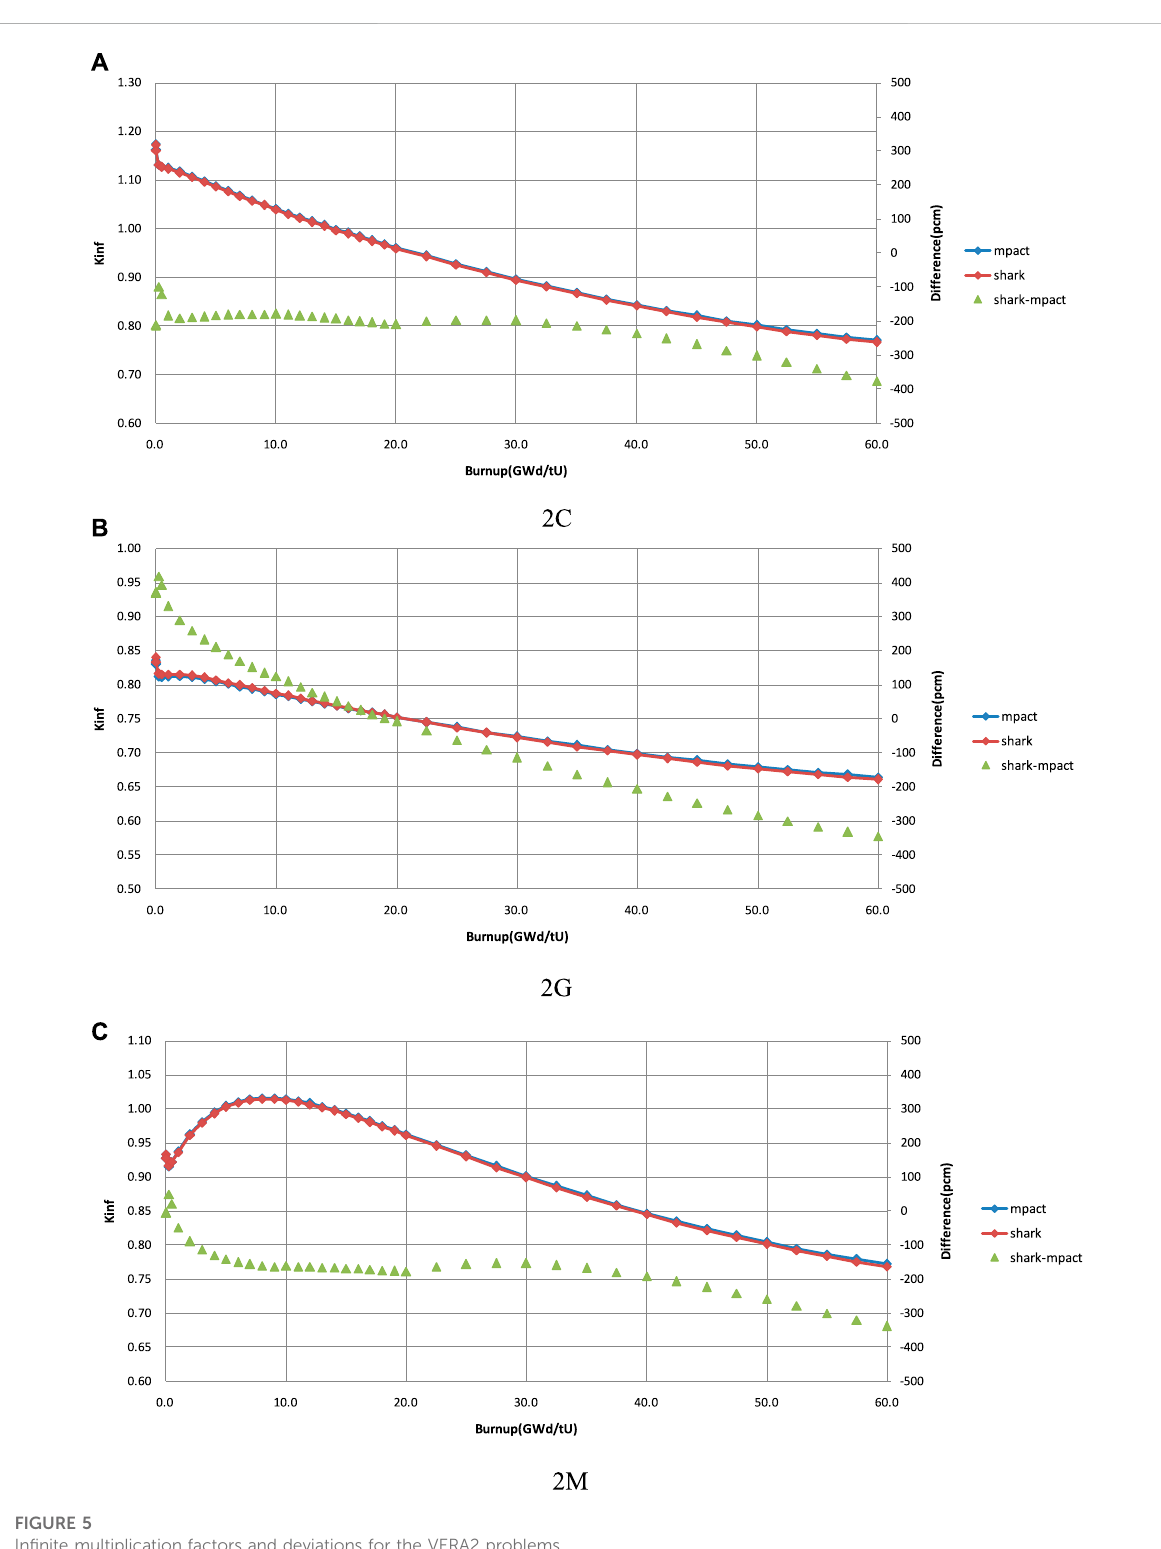
FIGURE 5 In fi nite multiplication factors and deviations for the VERA2